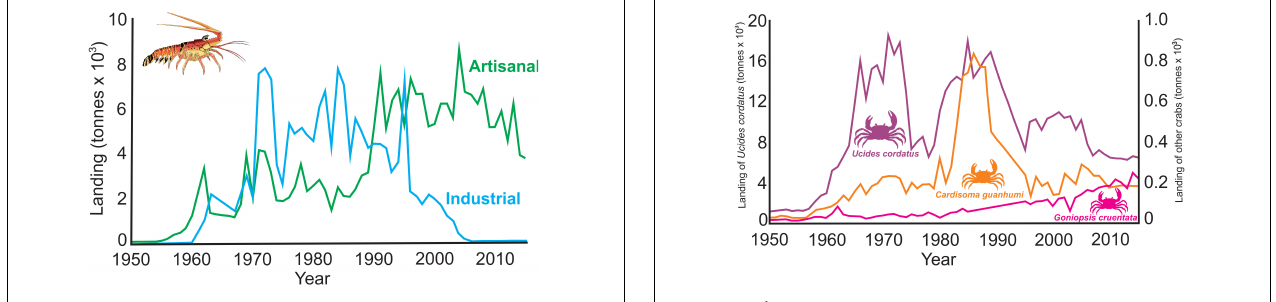
FIGURE 11 | Landing for the main crabs caught in Brazilian waters (1950–2015). Note the different scales for Ucides cordatus and the other crab species.